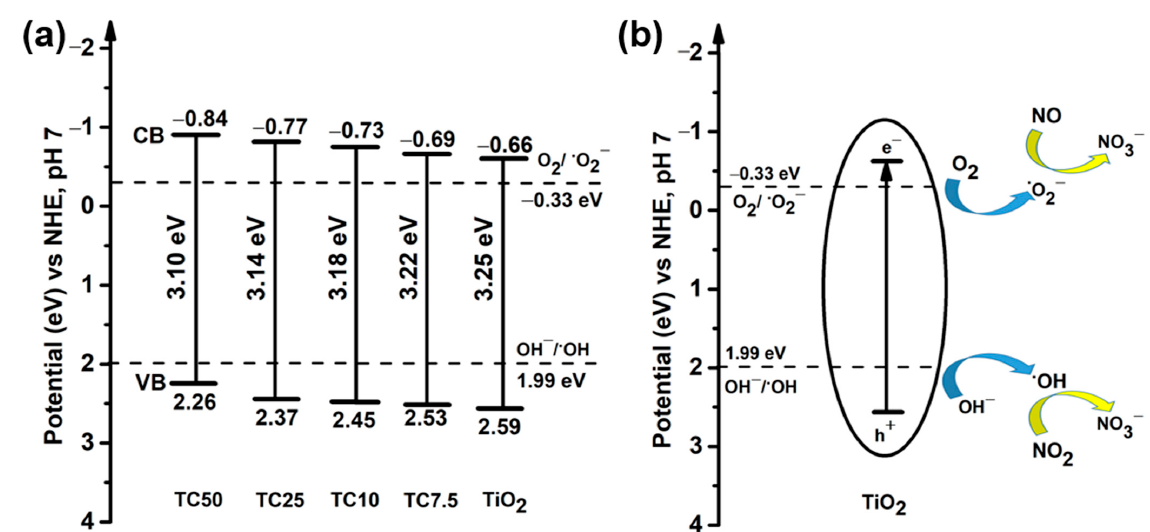
Figure 6. ( a ) Energy diagram with an energy bandgap, CB and VB edge potentials of pure TiO 2 P25 and N-doped TiO 2 materials, and ( b ) schematic for NO oxidation mechanism of TiO 2 under light irradiation. Figure 7 demonstrates the time profile for NO, NO 2 , and NO x and the efficiency of NO removal, NO 2 generation, NO x removal, and NO 3 − selectivity of pure TiO 2 P25 and the synthesized N-doped TiO 2 sample under both UV and visible light irradiation, respec- tively, for 1h. All samples compared to pure TiO 2 P25 exhibited enhanced NO oxidation. Under UV irradiation (Figure 7a, Table S4), the TC10 sample exhibited the maximum NO removal with a superior efficiency of 59% compared to the pure TiO 2 P25 (47%), approximately 1.26 times higher. The NO x removal efficiency of the TC10 (34%) was increased by 17% compared to TiO 2 P25 (17%) under UV irradiation. The intensified NO expulsion could be clarified by the fact the narrow energy bandgap with more negative CB potentials facilitates the reduction of O 2 to O 2 − radicals and, thus, intensifies the for- mation of the photo-oxidation product (i.e., NO 3 − ). It is further validated by the decreasing trend of the NO 2 generation rate. Here, NO 2 generation was decreased (Figure 7c) over TC10 compared to TiO 2 , which leads to higher NO x removal. Under visible light irradiation (Figure 7b, Table S5), all the synthesized N-doped TiO 2 materials exhibited significantly enhanced photocatalytic performance in both NO and NO x removal compared to pure TiO 2 P25 samples, though the NO 2 generation is relatively higher than pure TiO 2 . Among all the samples, TC10 showed maximum NO and NO x removals of 51% and 29%, respectively, almost 2.55 and 2.23 times higher than the pure TiO 2 P25 of 20% and 13%. Nitrogen doping into the TiO 2 lattice enhanced the absorption ability towards the visible light region and narrowed the energy bandgap with more neg- ative CB potentials, which enhanced the formation of superoxide radicals and, therefore, oxidation of NO. For practical application, the goal is to produce materials with high se-